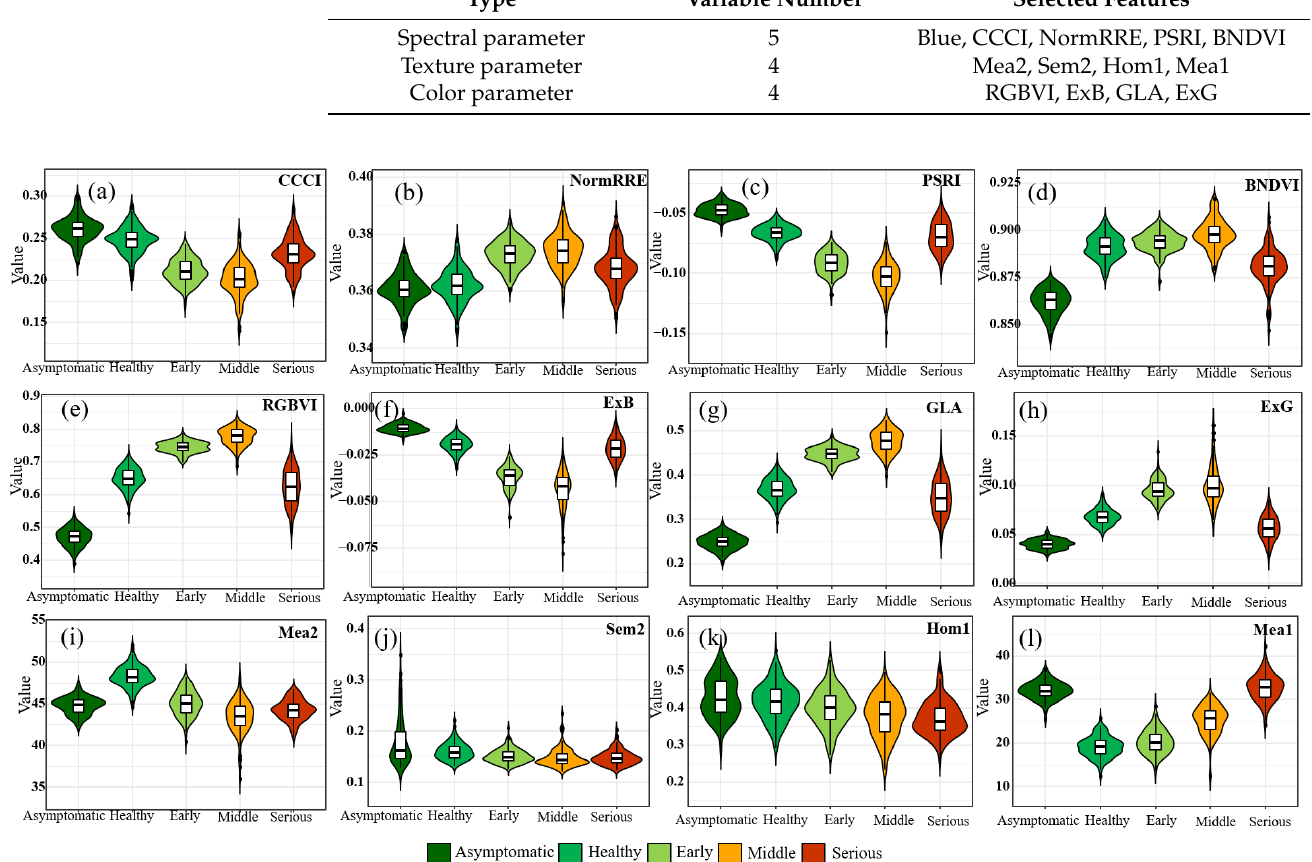
Figure 6. Change features of selected VIs, TFs, and CFs at different severity levels. ( a ) CCCI, ( b ) NormRRE, ( c ) PSRI, ( d ) BNDVI, ( i ) Mea2, ( j ) Sem2, ( k ) Hom1, ( l ) Mea1, ( e ) RGBVI, ( f ) ExB.( g ) GLA ( h ) ExG.